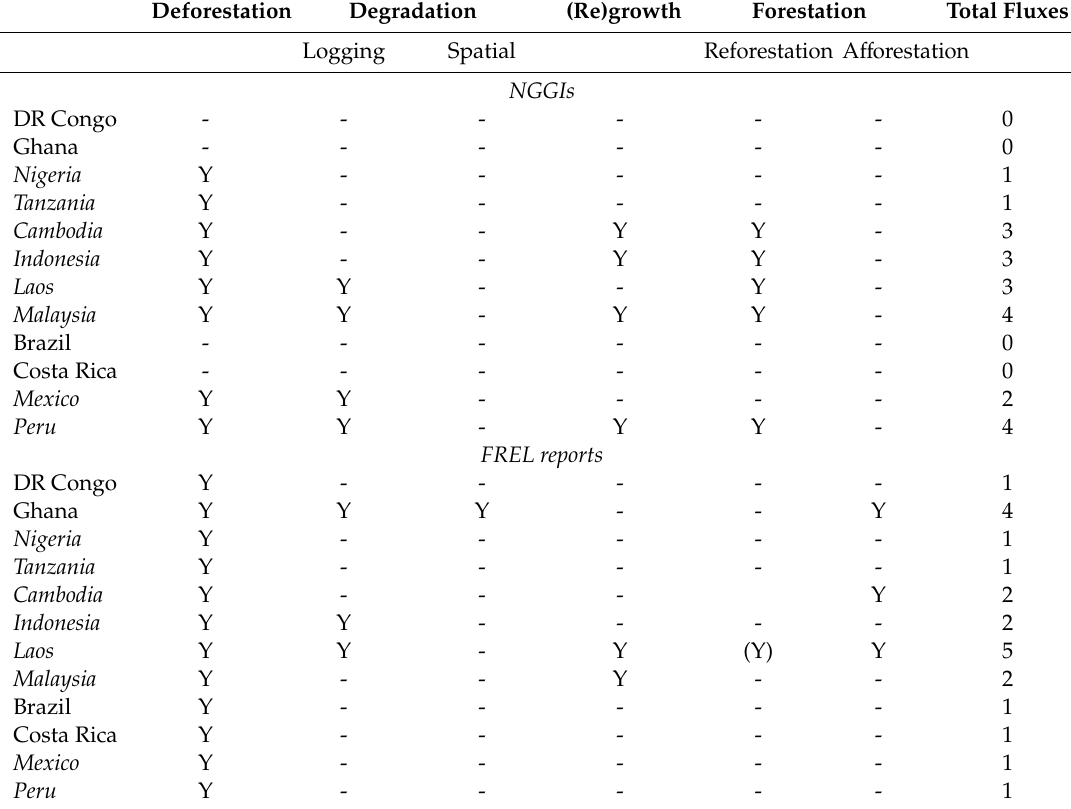
Table 6. Spatial and vertical underspecification uncertainties: the presence or absence of estimates of forest carbon fluxes in the National Greenhouse Gas Inventories (NGGIs) and Forest Reference Emission Level (FREL) reports of twelve tropical countries [54–77], showing in italics the set of eight countries whose estimates are compared in Table